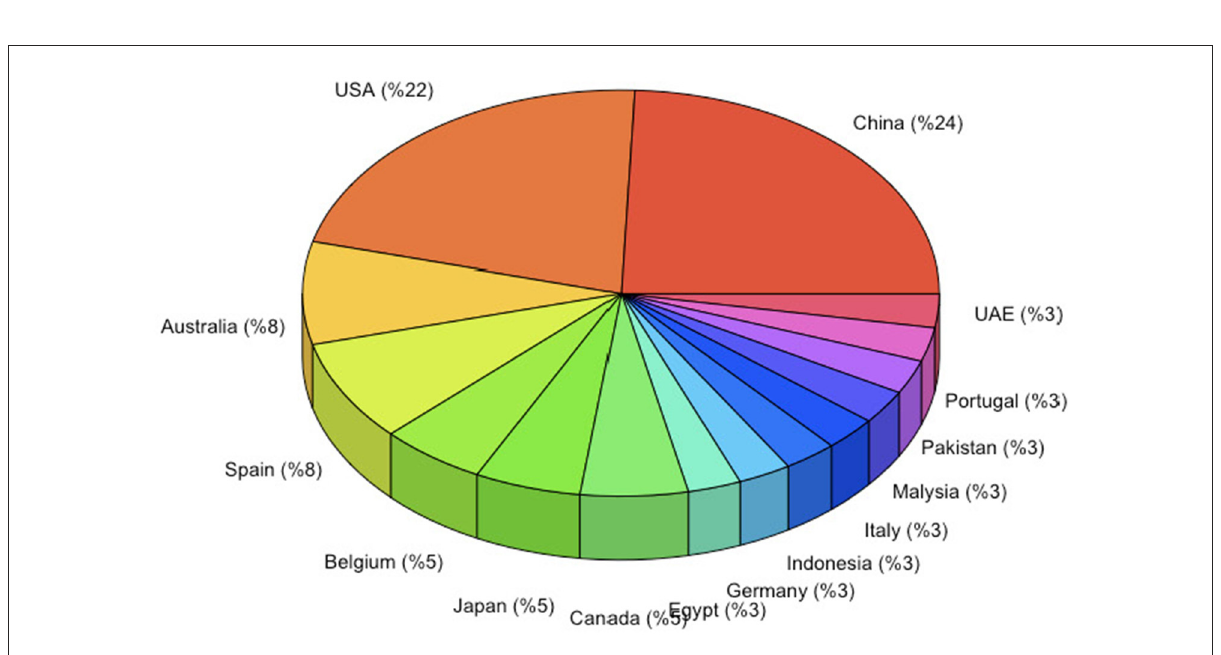
FIGURE3 Distributions of the publications by